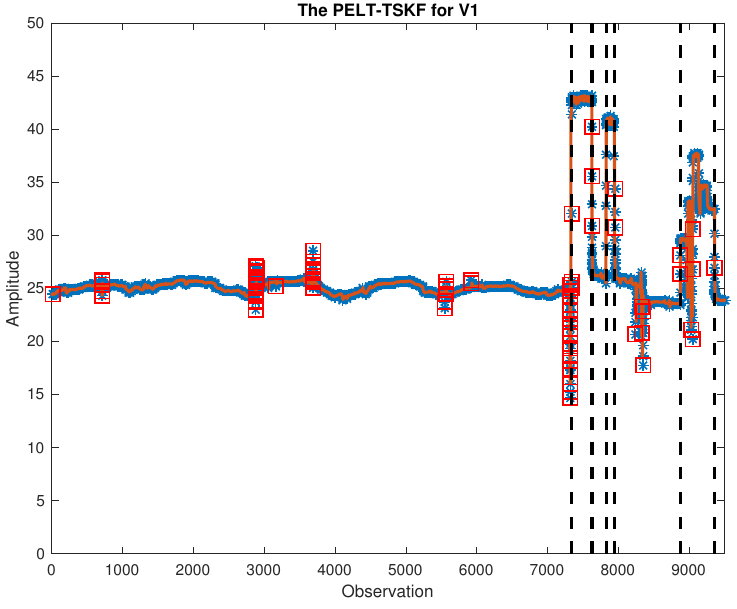
Figure 8. PELT-TSKF for